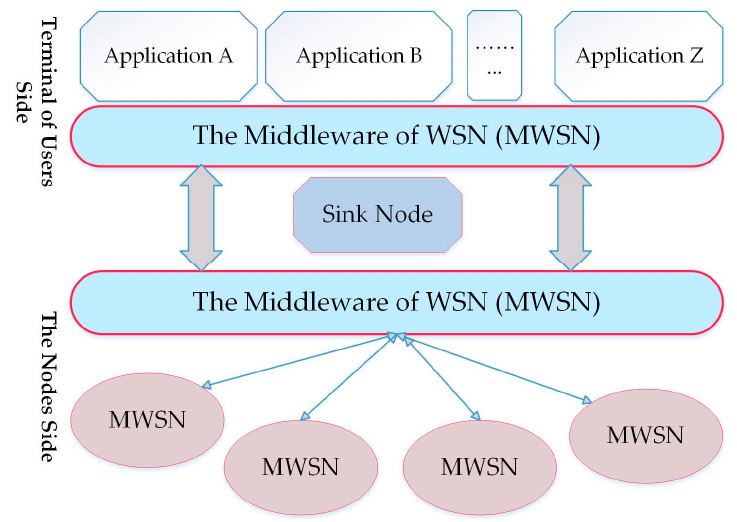
Figure 1. Middleware Architecture for WSN [13].